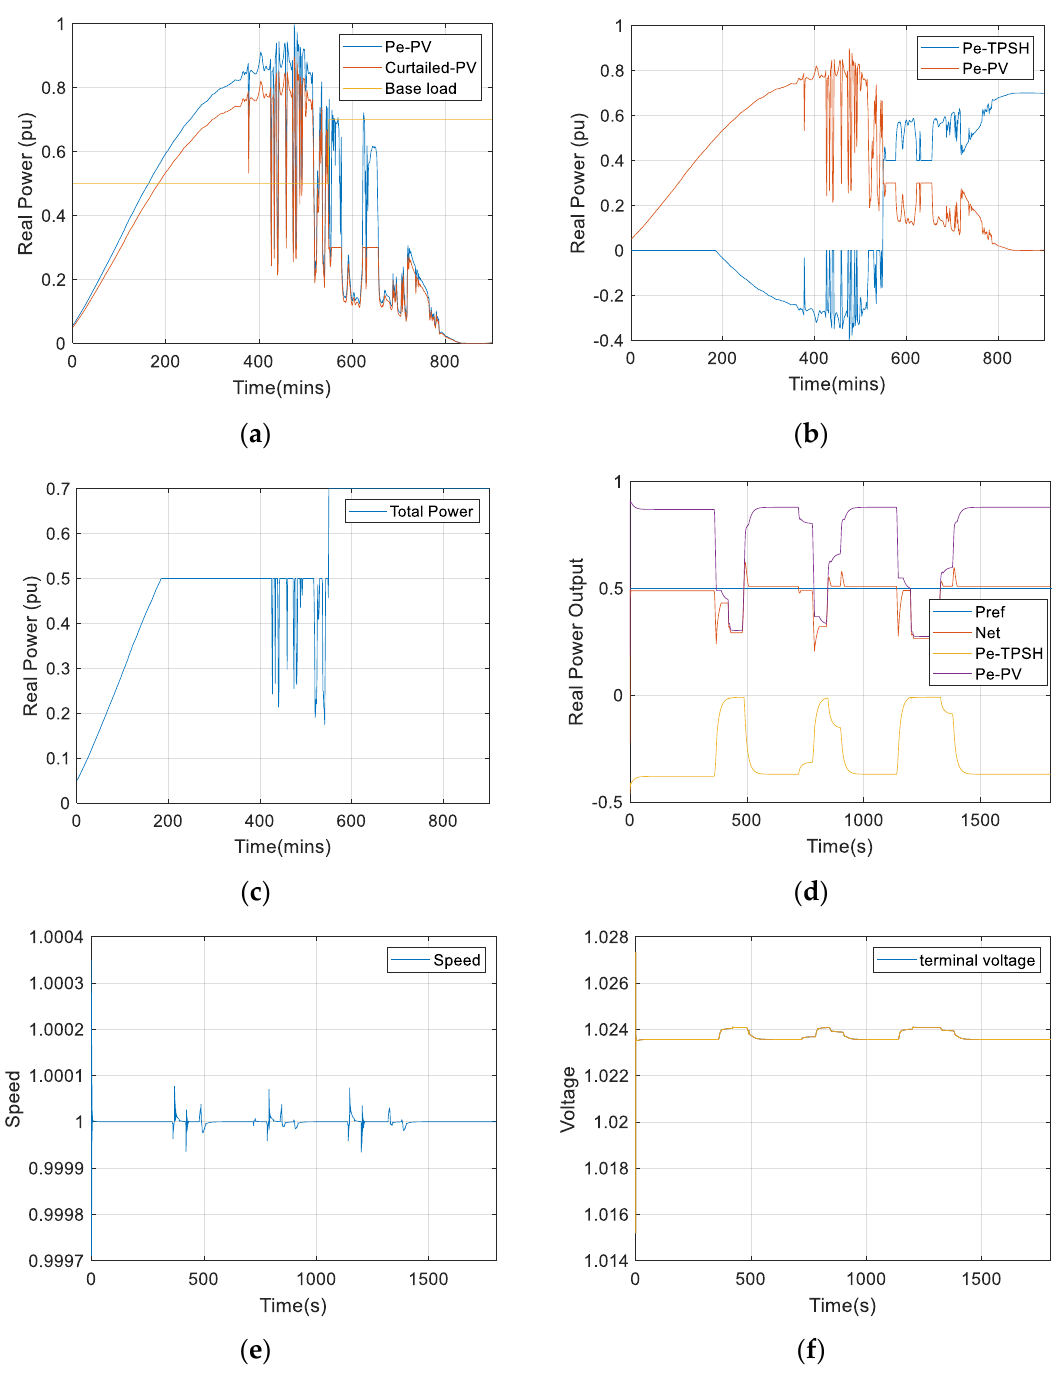
Figure 10. PV firming from t = 420 min to t = 450 min showing ( a ) irradiance profile, ( b ) required TPSH power to meet baseload, ( c ) firmed PV power ( d ) power output from PV and TPSH during dynamic simulation to meet set-point ( e ) speed and ( f ) terminal voltage during simulation.